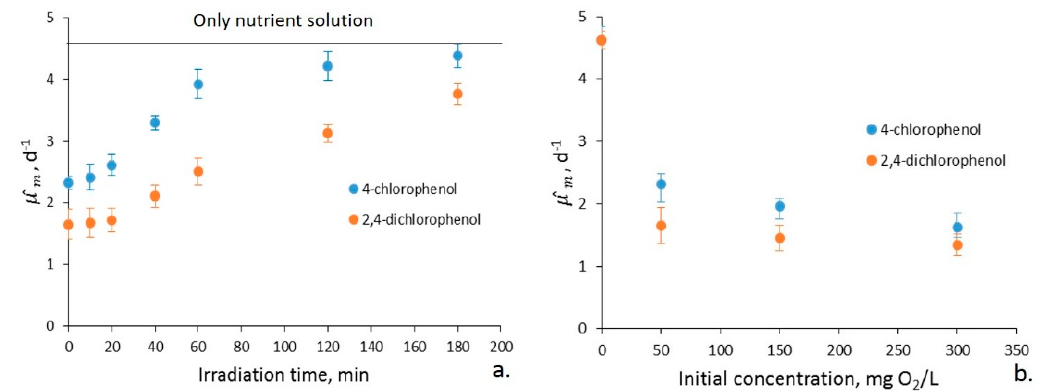
Figure 9. Evolution of the maximum specific heterotrophic growth rate of activated sludge depending on: ( a ) irradiation time (chlorophenol initial concentration of 300 mg O 2 / L), ( b ) the initial substrate concentration (without irradiation). Error bars represent the calculated standard deviation for the experimental data.